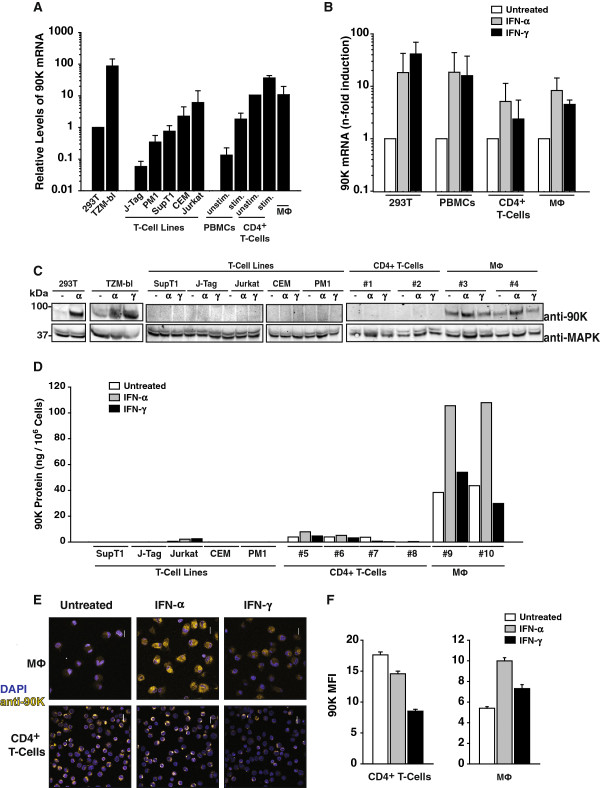
Expression and susceptibility to IFN stimulation of 90K in primary HIV-1 target cells. (A) cDNA was prepared from total RNA of the indicated cell lines and primary cells, and analyzed for relative 90K mRNA expression by TaqMan-based quantitative PCR with RNaseP expression as a reference. Depicted is the relative level of 90K expression, and values obtained for 293T cells were arbitrarily set to 1. Histograms represent arithmetic means ± S.E.M. of three independent experiments, except for the data for CD4+ T-cells, which shows arithmetic means of two experiments. (B) Indicated primary cell cultures were treated with IFN-α (100 U/ml) or IFN-γ (100 U/ml) for 24-48 hours, or left untreated, prior to RNA isolation and cDNA synthesis. Shown is the fold increase of 90K mRNA level from 2-3 experiments, each performed in duplicates. (C) Western Blot analysis of indicated cells treated with IFN-α (100 U/ml) or IFN-γ (100 U/ml) for 48 hours, or left untreated. (D) Anti-90K ELISA of cell lysates, following treatment with IFN-α (100 U/ml) or IFN-γ (100 U/ml) for 48 hours where indicated. (E) Immunofluorescence stain of indicated primary cell cultures. Cells treated with IFN-α (100 U/ml) or IFN-γ (100 U/ml) for 24-48 hours where indicated or left untreated. Scale bar: 10 μm. (F) Quantification of 90K immunofluorescence by KNIME image processing plug-in and the mean fluorescence intensity (MFI) signal per cell was determined. The data represent the arithmetic mean ± S.E.M. of 154 untreated, 259 IFN-α-treated and 147 IFN-γ-treated T-cells and the mean of 85 untreated, 121 IFN-α-treated and 64 IFN-γ-treated macrophages.